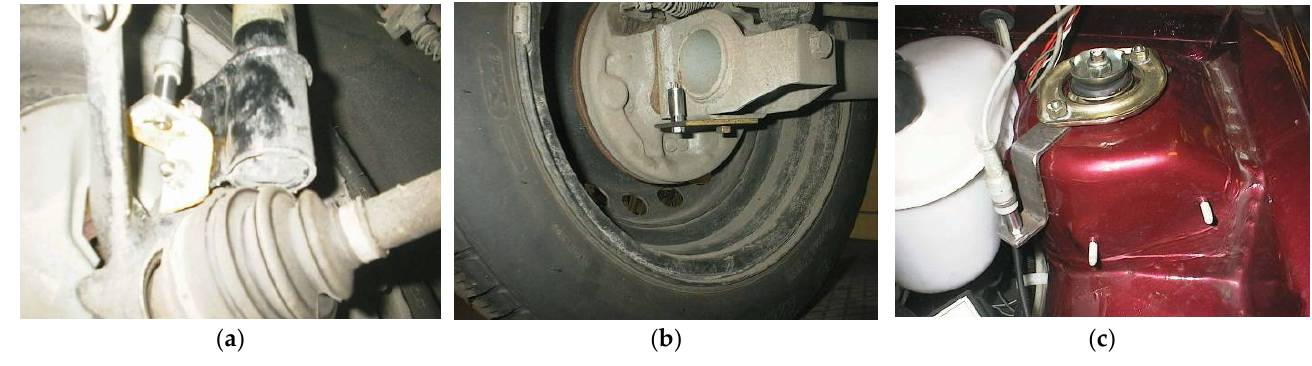
Figure 4. Vertical acceleration sensors: ( a ) at the centers of the front wheels [31]; ( b ) at the centers of the rear wheels [31]; ( c ) at the top of the front left shock absorber.